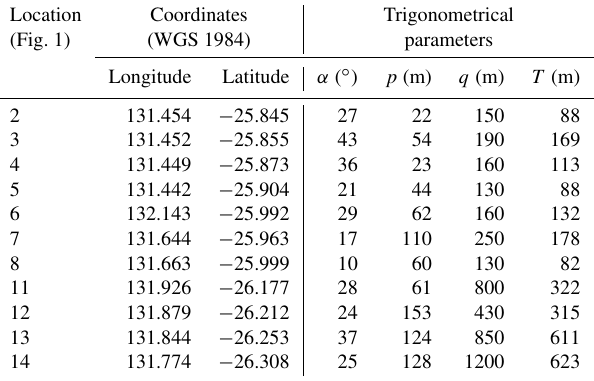
Table 1. Angle of dip ( α ), elevation difference ( p ), apparent thick- ness ( q ), and true thickness ( T ) of the Woodroffe Thrust mylonites in the central Musgrave